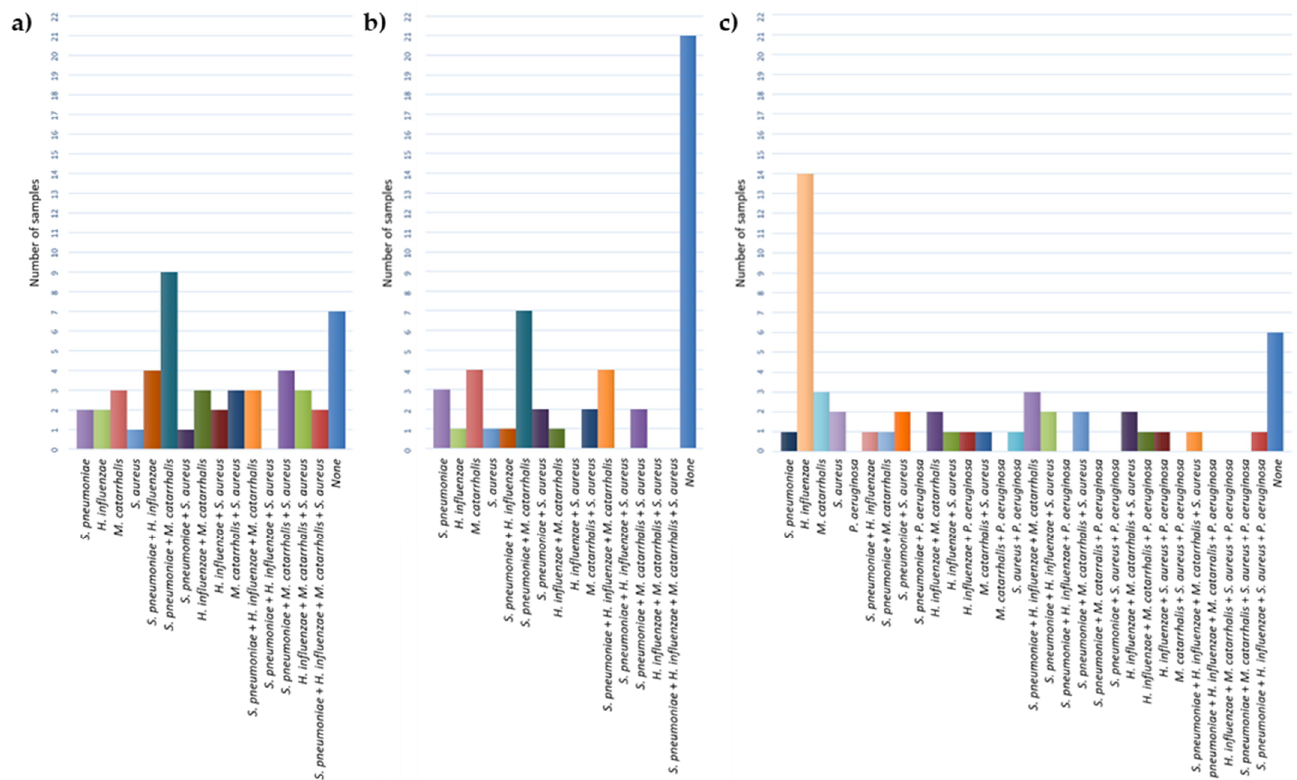
Figure 3. Species combinations in NP and MEF: ( a ) Species in NP identified by culture; ( b ) Species in MEF identified by culture; ( c ) Species in MEF identified by qPCR.